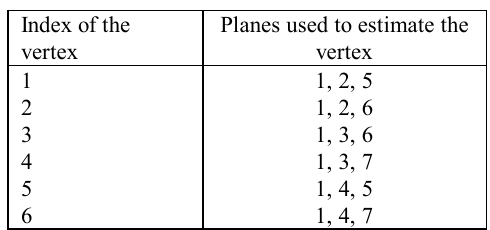
Table 3. Map of the index of each vertex and the planes used to estimate it for Scenario 1.